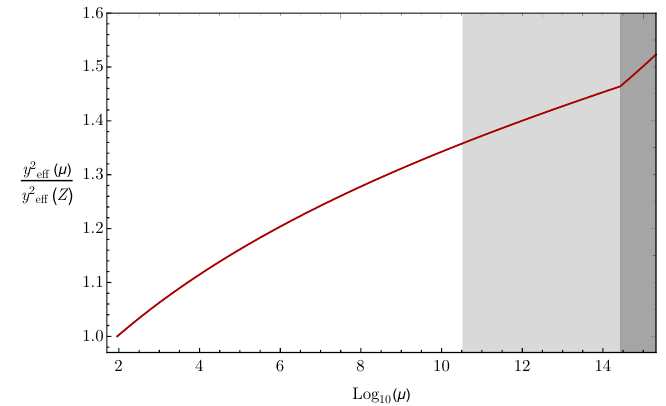
Figure 4 . Running of the squared effective Yukawa coupling y 2 from the Z mass scale to the U(1) symmetry breaking scale M . The mass threshold of the lightest RHN ( N 3 ) is shown in light gray, while the mass threshold of the heaviest degenerate RHN ( N 1 , 2 ) is shown in dark